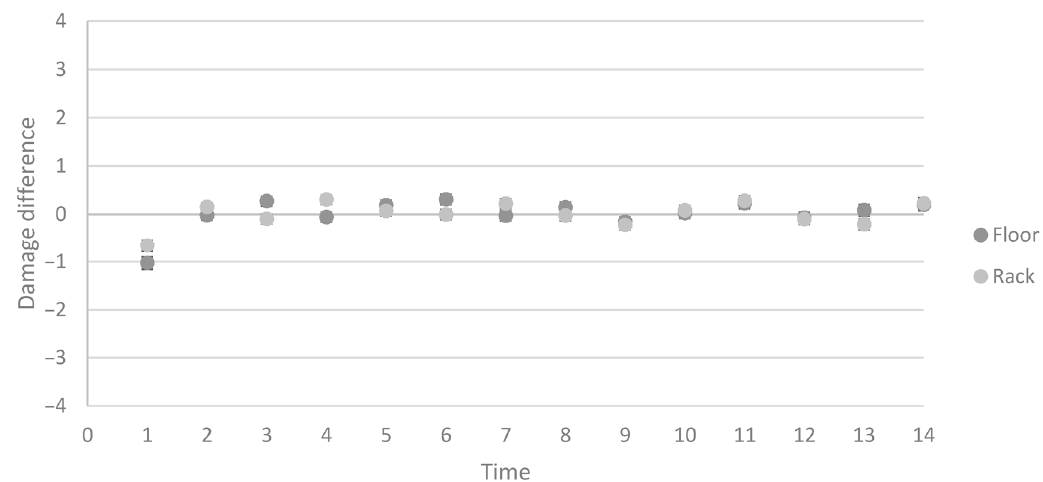
Figure 5. Estimated mean tail damage difference over time (once per week during the production period) in the Floor and Rack treatments. The error bars are standard error, visualizing when there is a treatment effect. n = 6053.